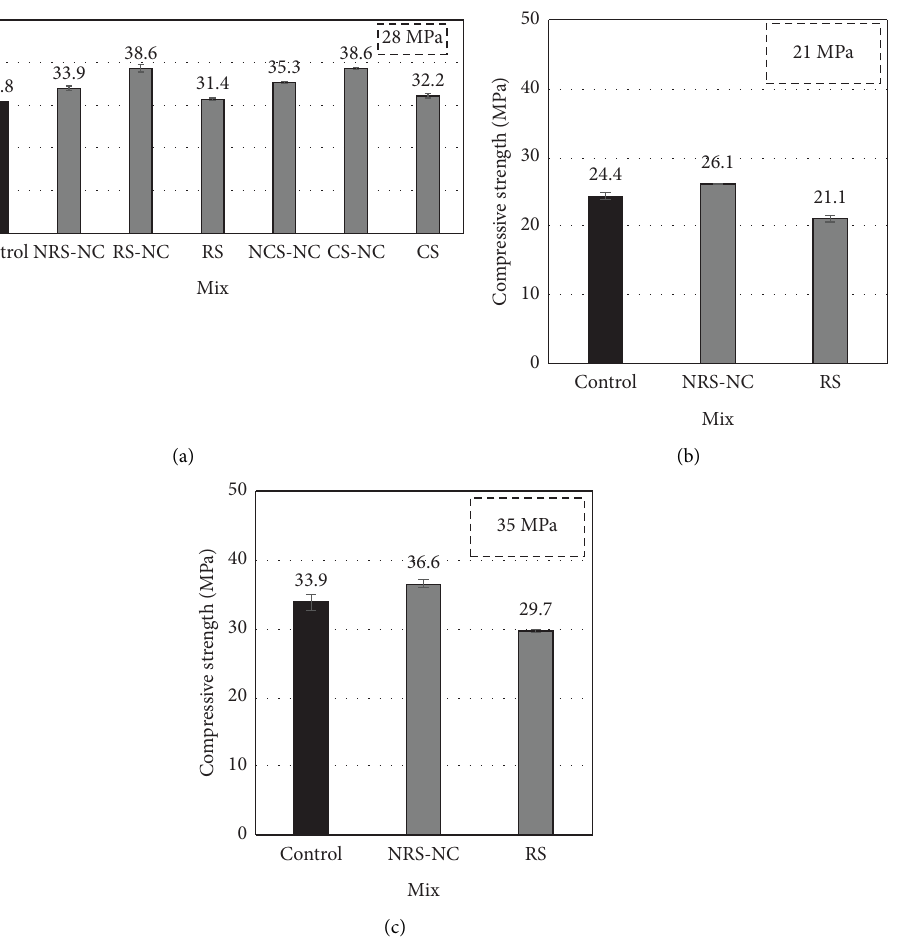
Figure 7: Compressive strength (average) (a) for 28MPa, (b) for 21 MPa, and (c) for 35MPa concrete.